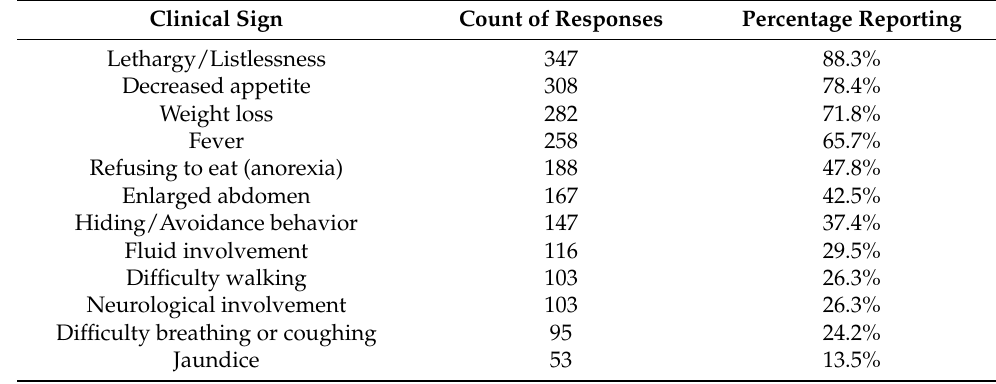
Table 4. Clinical signs reported in cats treated with GS-441524. Owners were able to list more than one source, so the total number of responses is higher than the total number of respondents.